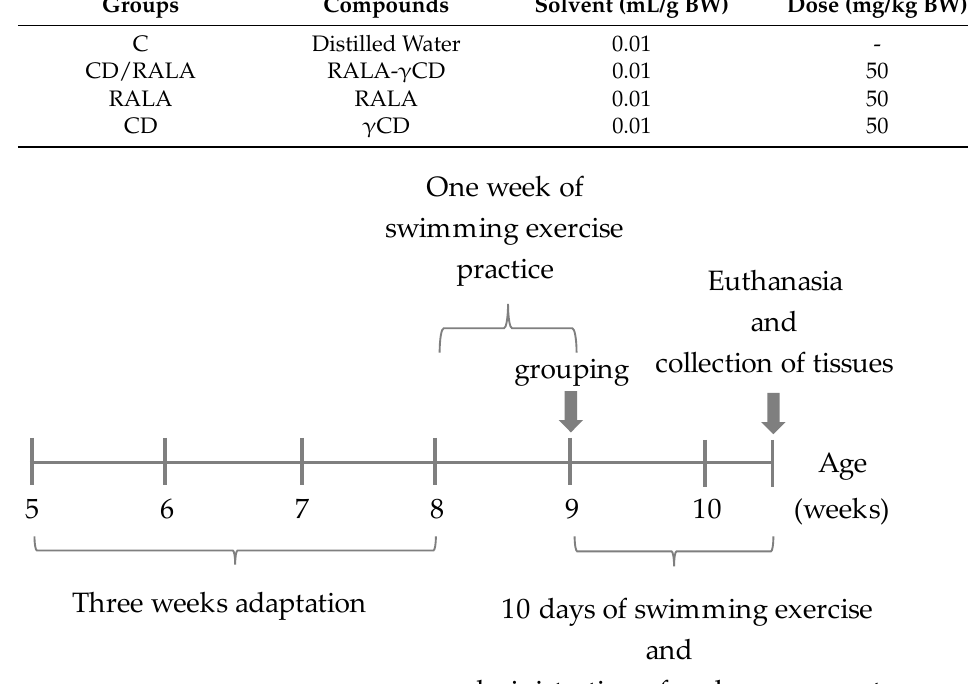
Table 1. Experimental groups and dose of administered substance.